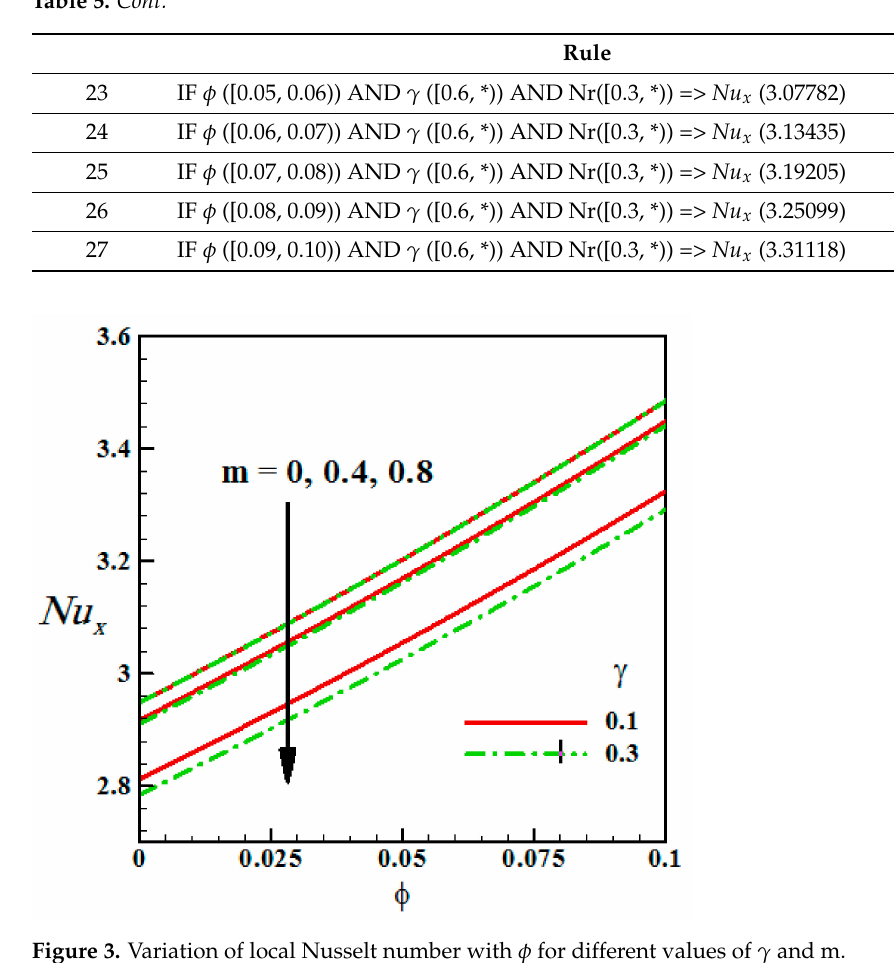
Figure 3. Variation of local Nusselt number with φ for different values of γ and m.